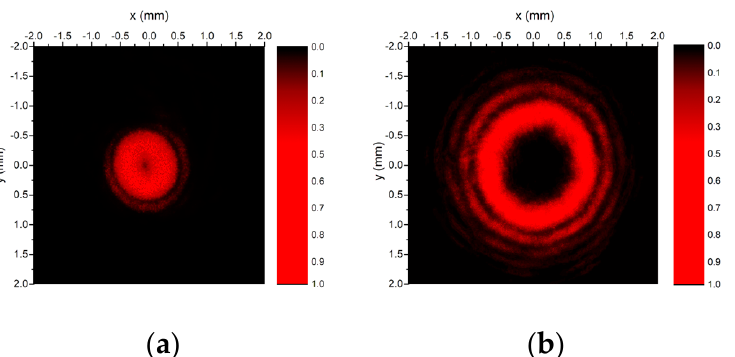
Figure 13. Measured intensity distribution of the beam generated by ( a ) a spiral axicon of order 1, and ( b ) a spiral axicon of order 4.